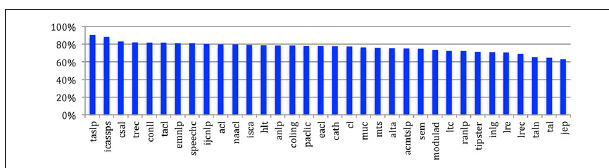
FIGURE 26 | Percentage of male authors across the